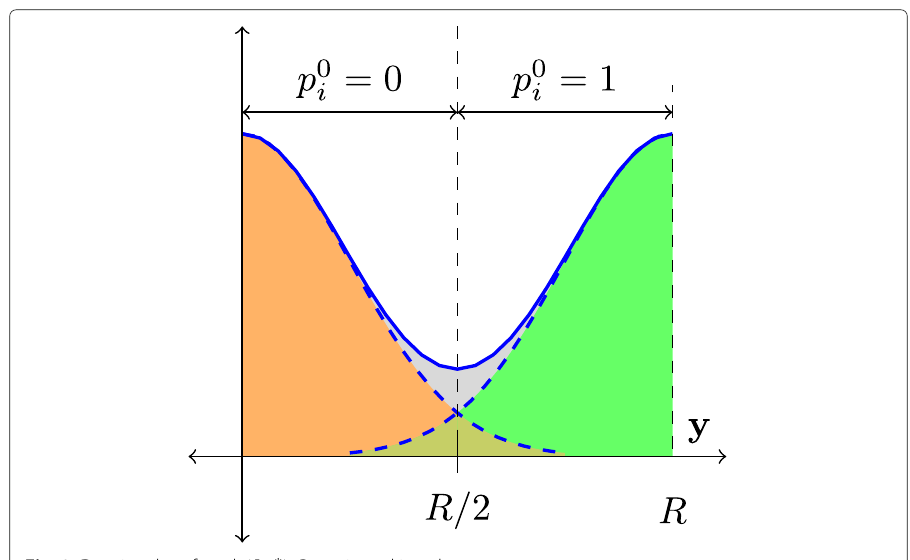
Fig. 2 Density plot ofmod ( Ax ∗ ) . Best viewed in